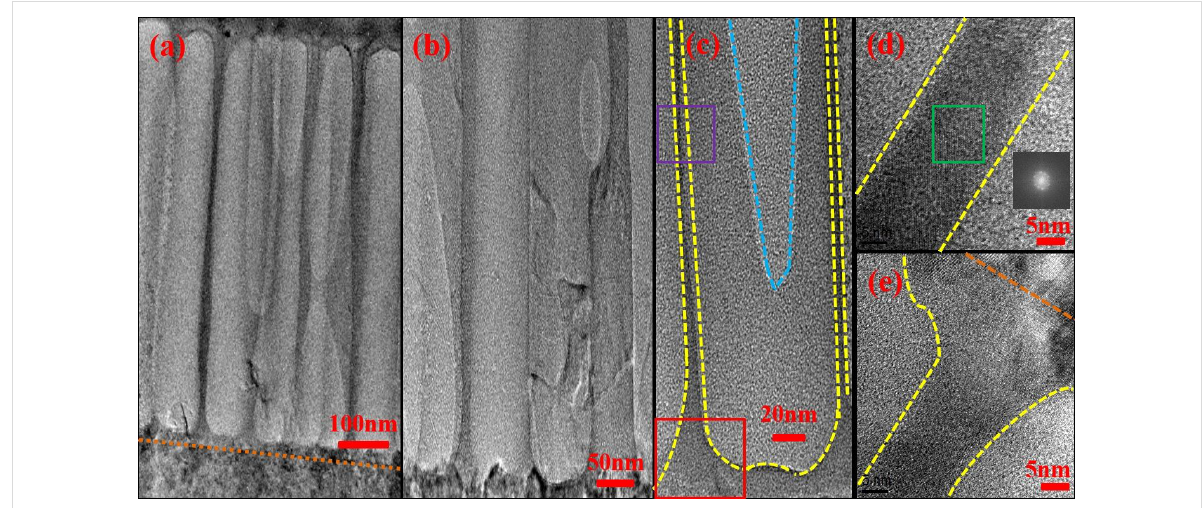
Figure 3: Transmission electron microscopy measurements for sample AAO60 at different magnifications: (a) complete pores exist at the sapphire substrate; (b) a magnified view of (a); (c) a magnified view of the single pore shown in (b); (d) a magnified view of the region defined by the purple rectangle in (c); and (e) a magnified view of the red rectangle region shown in